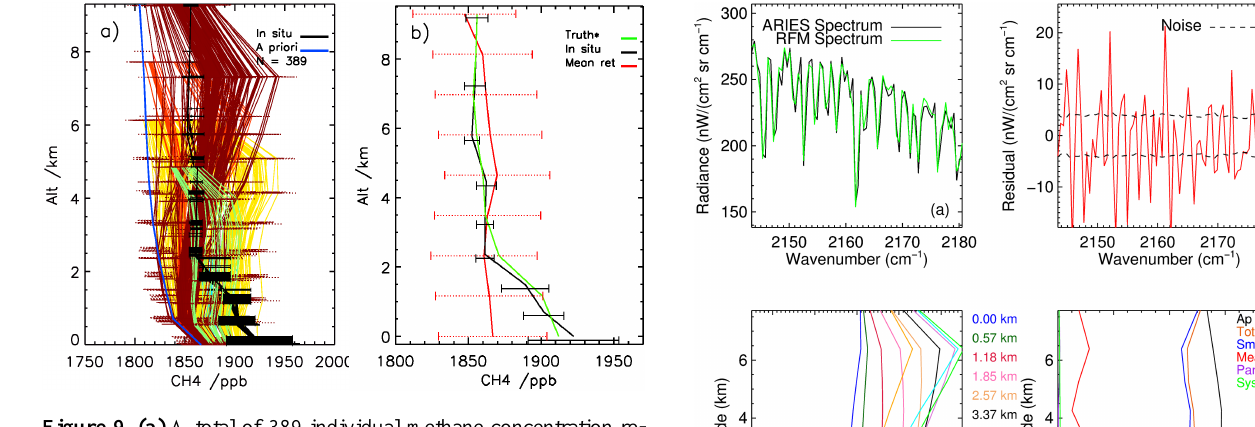
Figure 9. (a) A total of 389 individual methane concentration re- trieval profiles across flight B725 colour coded for observer (flight) altitude (red = 8.7km, yellow = 6.1km, green = 4.8km). Retrieval uncertainty (total error) is shown as the dotted bars in each case. In situ and a priori profiles are also shown as per legend. (b) Mean profiles from flight B725 for retrieved (red), in situ measured (black), and in situ average convolved with ARIES averaging ker- nels (green). The in situ 1 σ measurement variability is shown as black bars at each binned vertical level and the root mean square retrieval uncertainty (total error) is shown by the red bars.